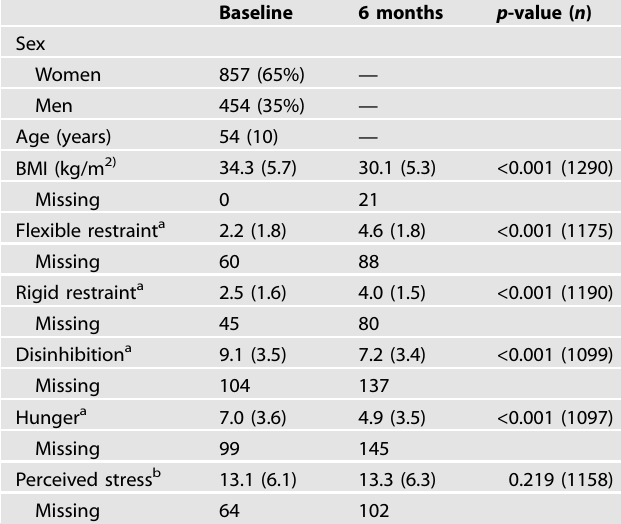
Table 1. Participant characteristics, eating behaviors, and perceived stress at baseline and at 6 months in PREVIEW participants who attended at least one follow-up visit after 6 month time point ( n =